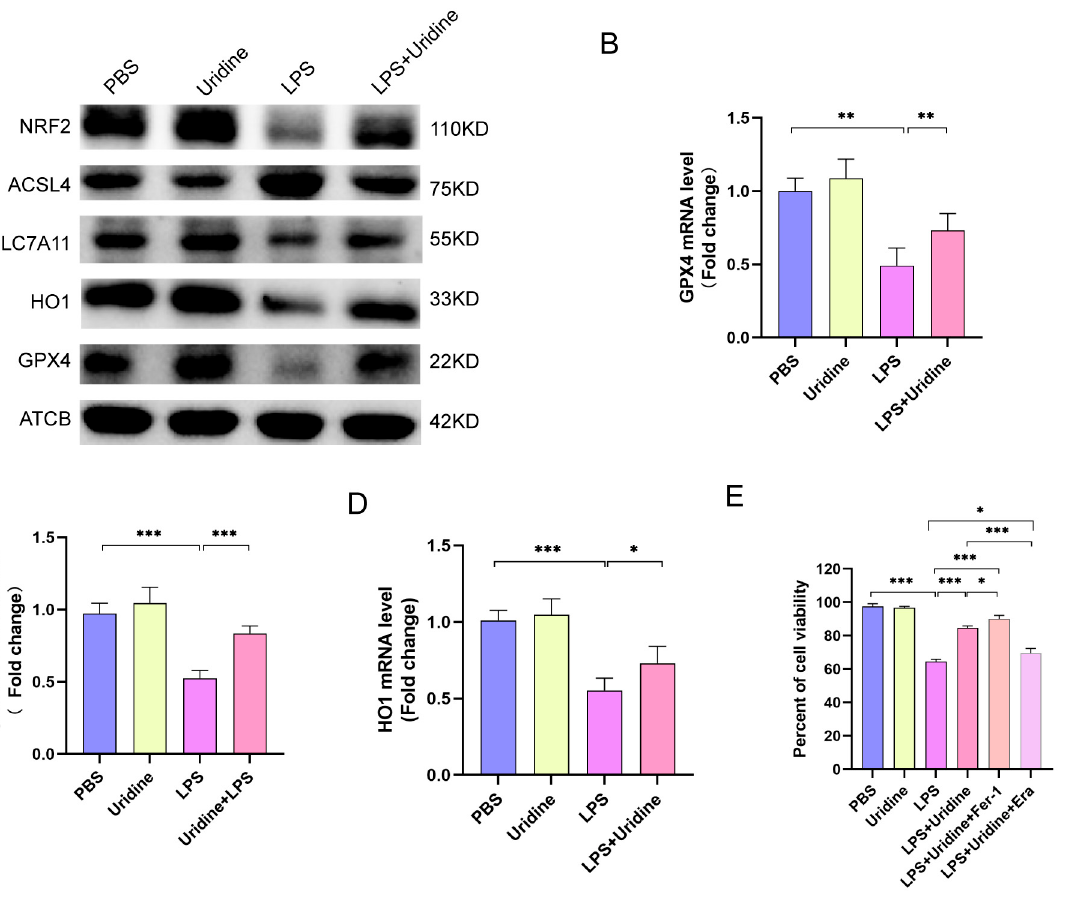
Figure 5. Uridine supplementation markedly suppressed ferroptosis in THP-1 cells after LPS stim- ulation. ( A ) Immunoblots for NRF2, ASCL4, SLC7A11, HO1, GPX4 and ATCB ( β -actin) in the indi- cated group either treated with LPS (10 μ g/mL) or uridine (200 μ M) or both. ( B – D ) Relative mRNA expression of GPX4, SLC7A11 and HO1 in the indicated group. ( E ) Cell viability determined by CCK8 assay in the indicated group. Fer-1 (Ferrostatin-1, 5 μ M) and Era (Erastin, 5 μ M) were treated 30 min after uridine supplementation. ( F ) Representative images of fluorescence probe for ROS. n = 6 per group (Data are presented as Mean ± SD, * p < 0.05, ** p < 0.01, *** p < 0.001 compared with indicated group). 2.6. Nrf2 Knockdown Abrogated the Ferroptosis Resistance Effect of Uridine To further validate the role of Nrf2 in the process of uridine combating ferroptosis, the Nrf2 was knockdown by siRNA and it successfully silenced Nrf2 expression in THP- 1 cells (Figure 6A). At the same time, GPX4, SLC7A11 and HO1 expression were signifi- cantly decreased after Nrf2 silence, and the protective effect of uridine was subdued (Fig- ure 6A). Otherwise, compared with LPS+uridine group, Nrf2 silence group had a lower cellular GSH level and higher MDA level (Figure 6B,C). Mitochondrial membrane poten-